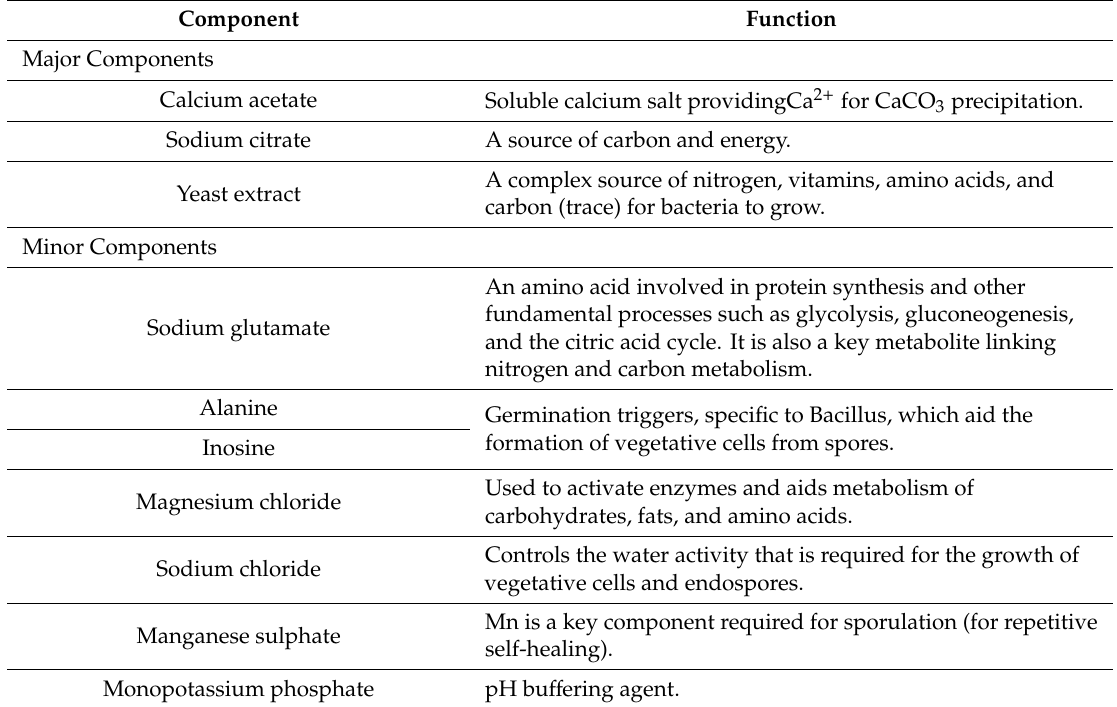
Table 1. Functions of individual components of growth